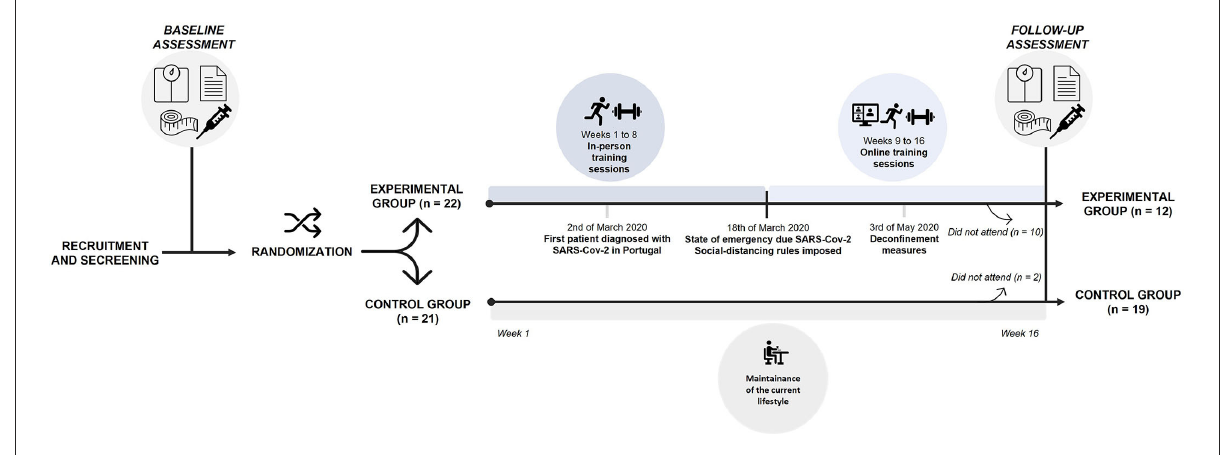
FIGURE1 Study design with critical time points and